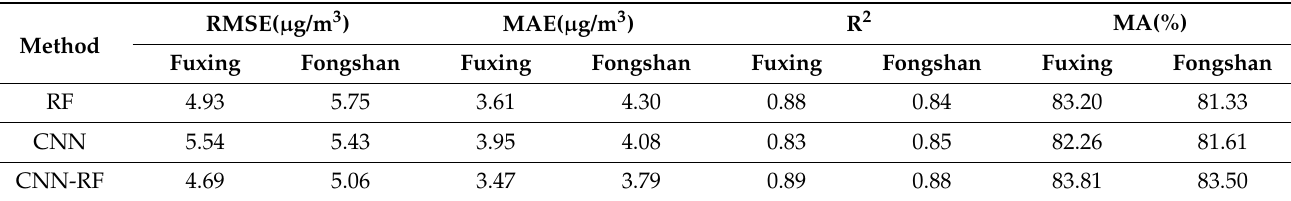
Table 4. Model performance at two testing stations.